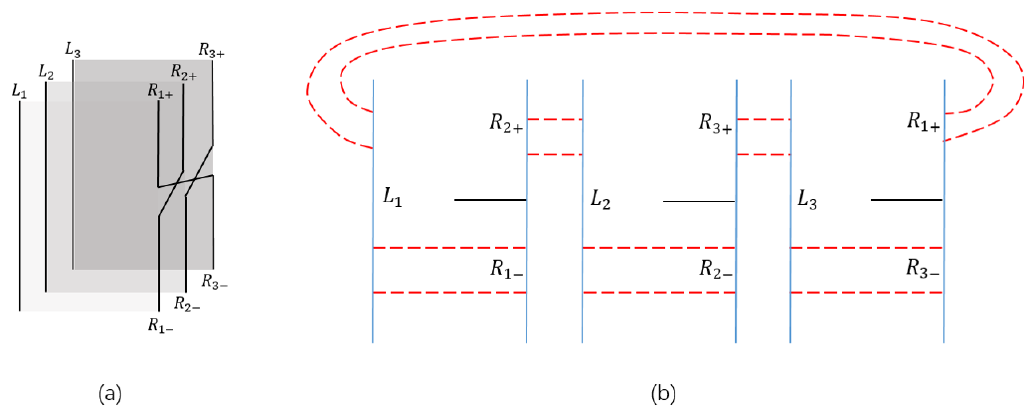
Figure 3 . Example with three replicas. In (a), we take three replicas, cut the right boundaries, and identify the boundary condition of R i (cid:0) with R i +1 ; + . Note the shaded grey area denotes nothing physical. In (b), we draw an equivalent way to picture the con(cid:12)guration. The red dashed lines represent the interaction between boundaries L i and R i .